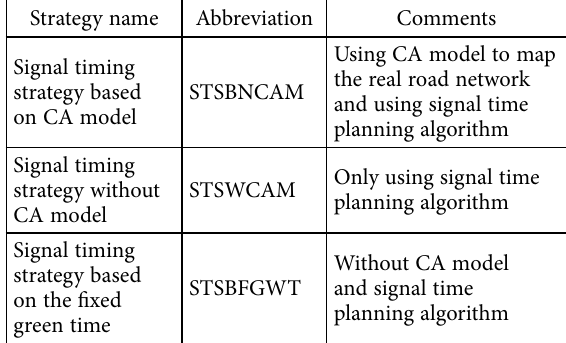
Table 5. The description of three strategies